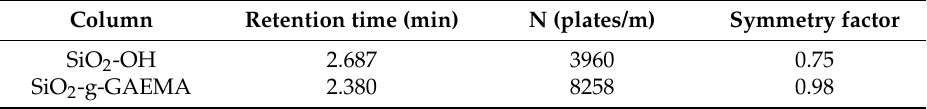
Figure 4. Hydrophilic interaction liquid chromatography (HILC) mode separation of uracil (200 ppm), adenosine (100 ppm), cytosine (50 ppm) and cytidine (200 ppm). Mobile phase: Acetonitrile/H 2 O (90:10); flow rate: 1 mL/min; column temperature: 30 °C; UV detection (254 nm). Dashed line is unmodified silica. Solid line indicates GAEMA grafted silica. Table 3. Column efficiency of SiO 2 -g-GAEMA